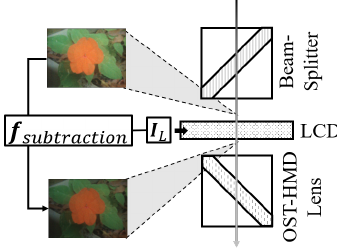
Figure 5. f subtraction : How much the LCD decreased the incoming light beyond f decay